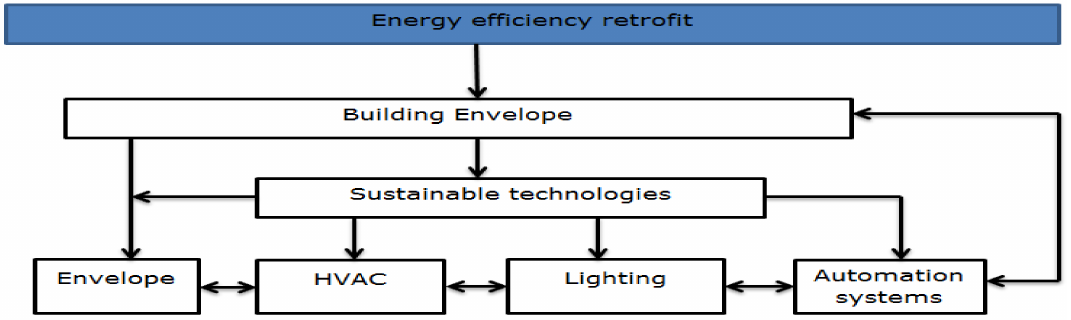
Figure 1. Framework of sustainable technology application adopted from